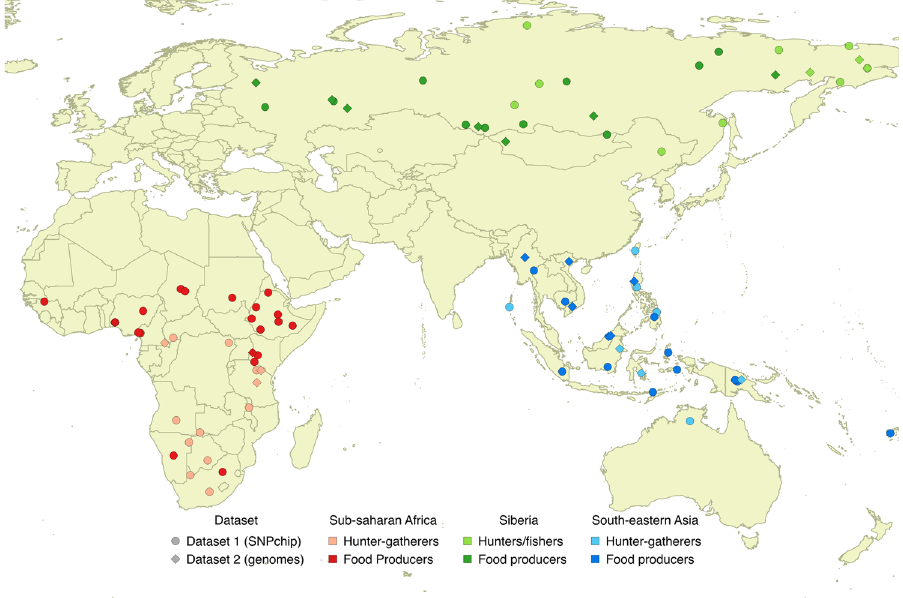
Figure 1. map of the populations considered in the present study. The map has been generated with the software QGIS, version 2.12.0-Lyon 60